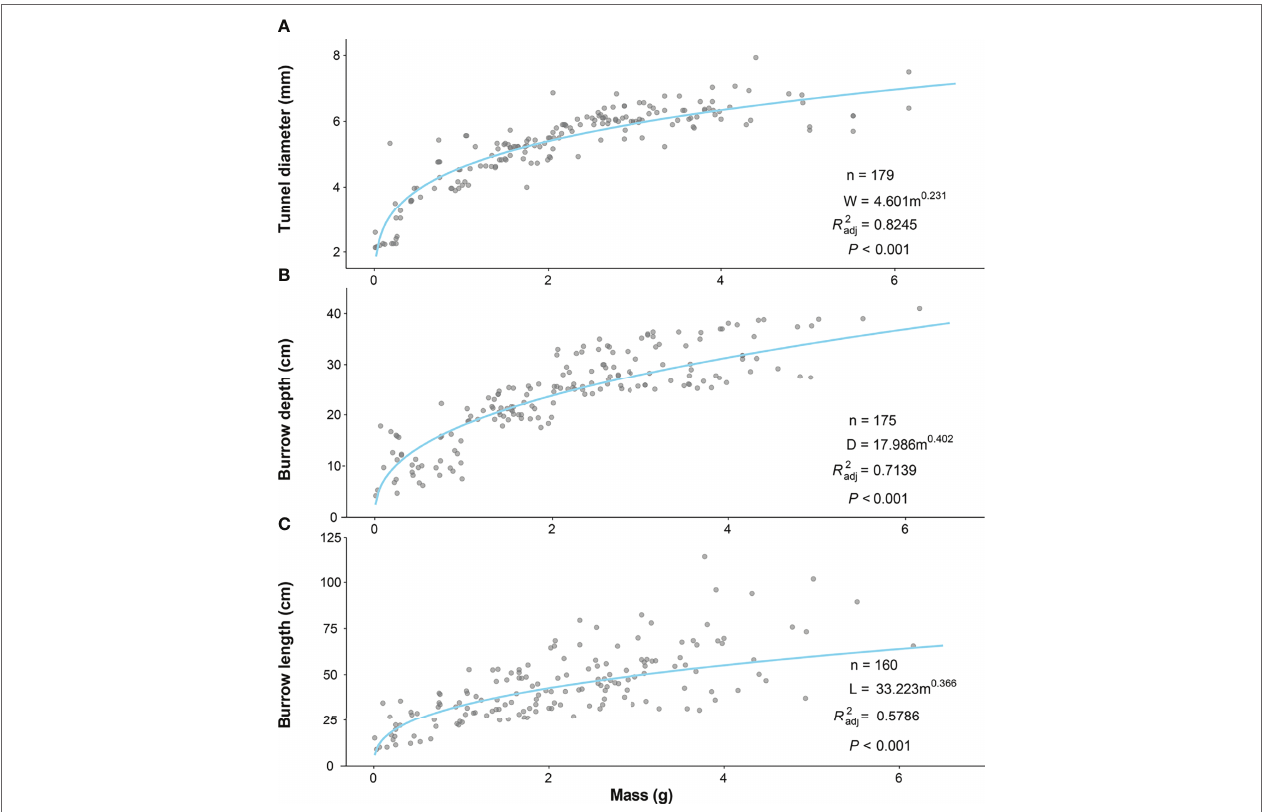
FIGURE 5 | Relationship between mass and tunnel diameter (A) and burrow depth (B) and burrow length (C) of P. aibuhitensis. The lines represent the least- squares linear regression of the filled symbols according to the inset equations.